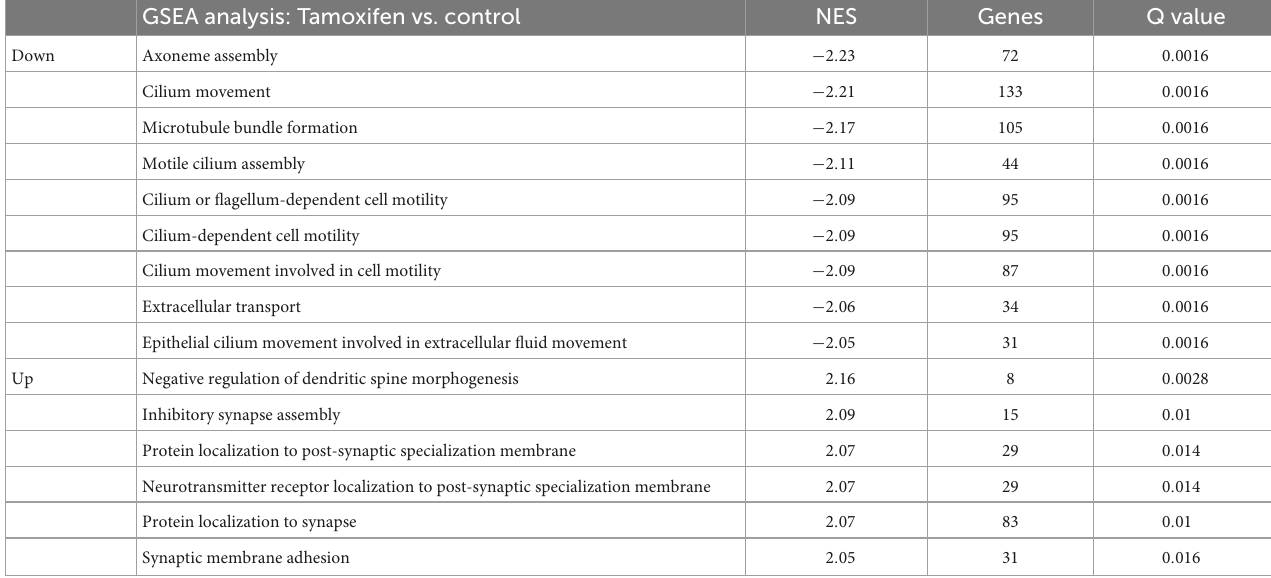
TABLE 3 Gene set enrichment analysis (GSEA)–biological pathways. GSEA analysis: Tamoxifen vs.